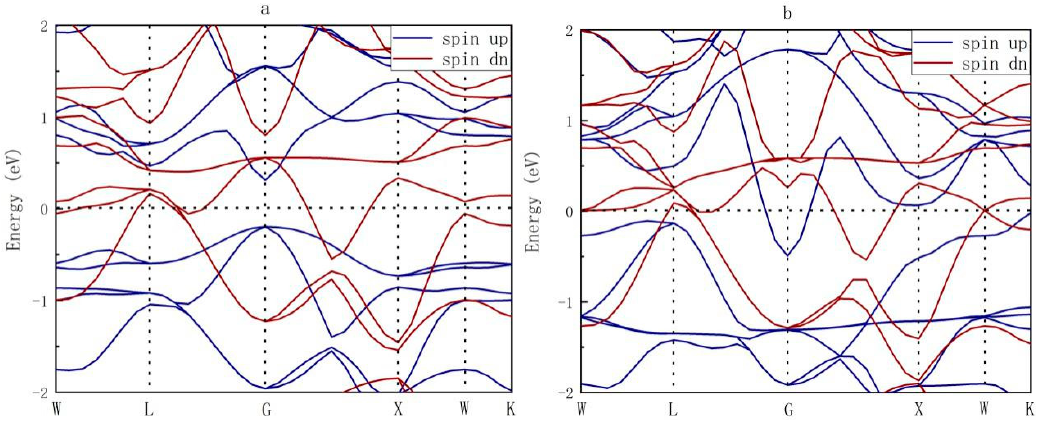
Figure 3. band structures for Sc 2 VGe: ( a ) XA type and ( b ) L2 1 type. Figure 3. Band structures for Sc 2 VGe: ( a ) XA type and ( b ) L2 1